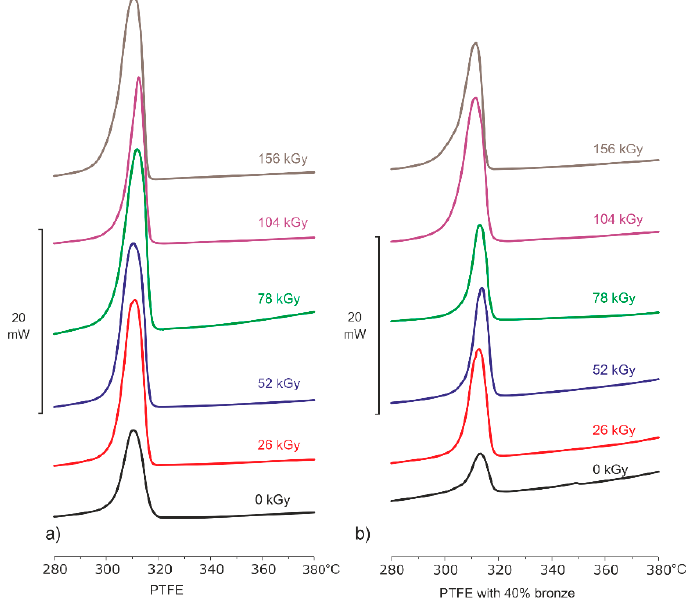
Figure 3. DSC thermograms for PTFE ( a ) and PTFE with 40% bronze ( b ) in their initial states and after electron beam irradiation, registered during the recrystallization process.